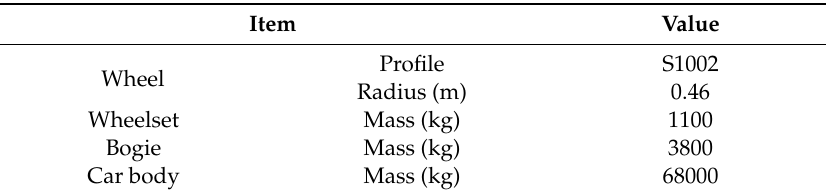
Table 1. Track parameters.